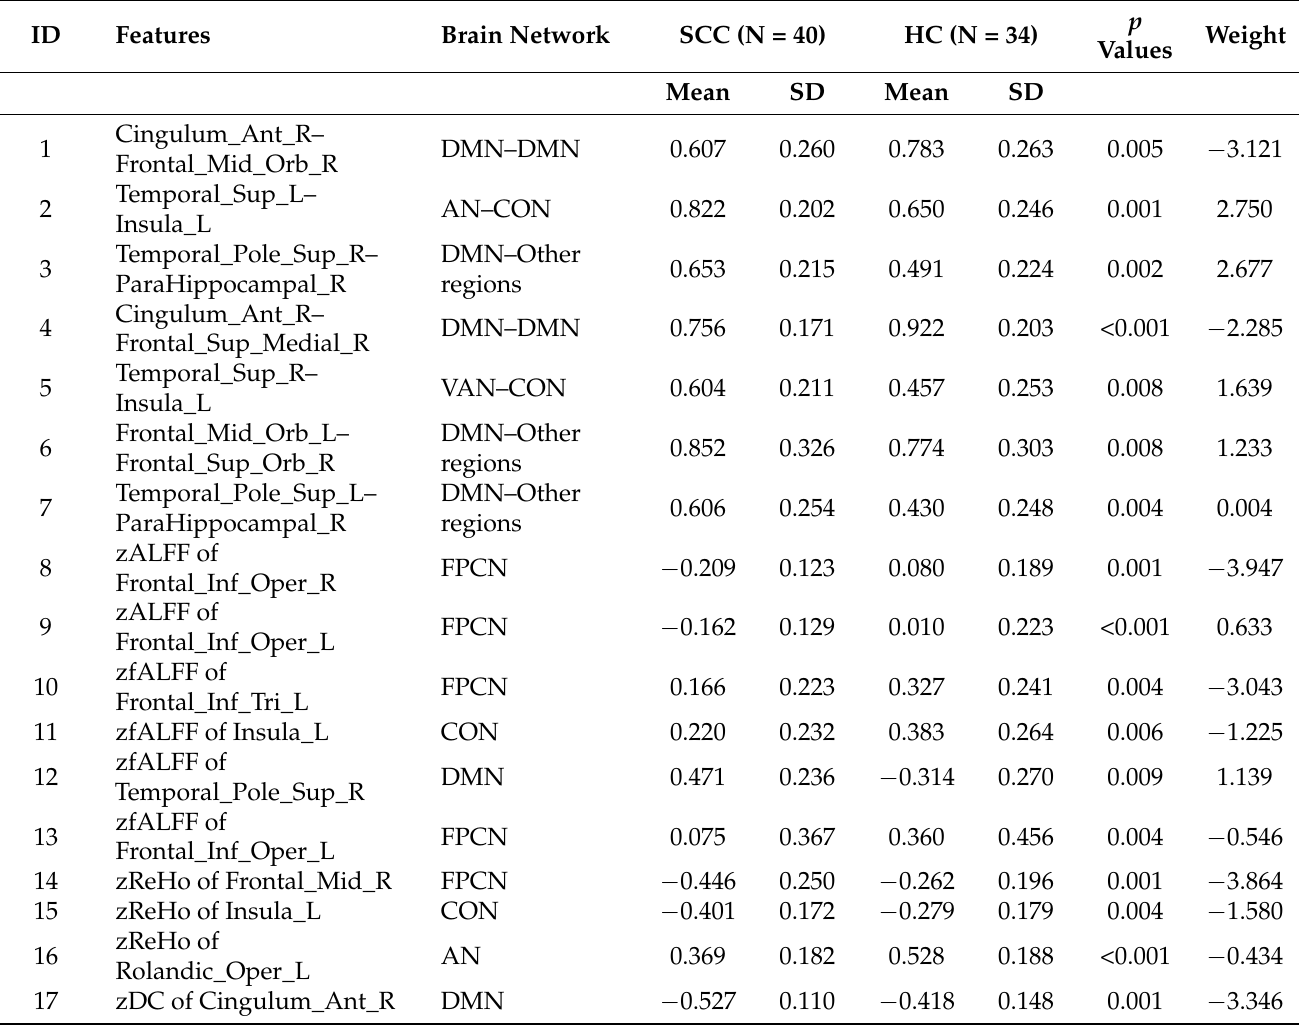
Table 3. The selected rs-fMRI features set for discriminating the SCC from HC